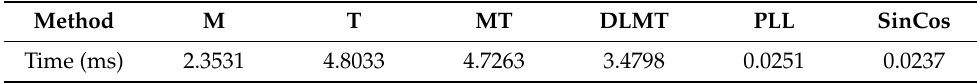
Table 2. Computational cost of the different